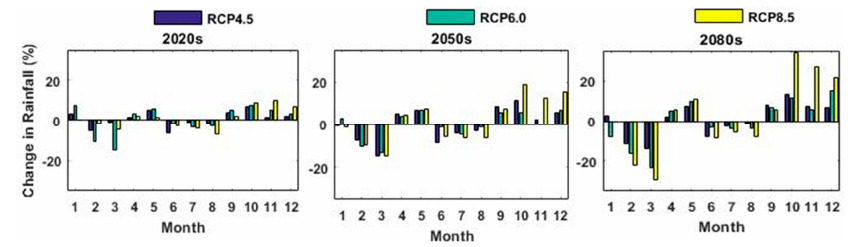
Figure 11. Mean monthly changes in rainfall (°C) for the future years (2020s, 2050s and 2080s) under the RCP4.5, 6.0 and 8.5 scenarios compared with the baseline period (1976–2005).